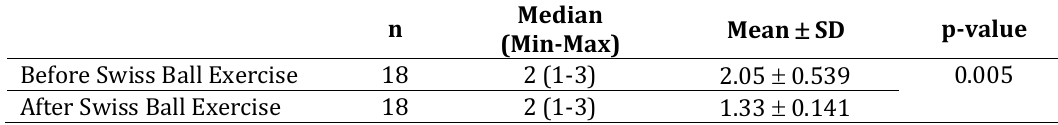
Wilcoxon Test Results with Berg Balance Scale in Intervention Group